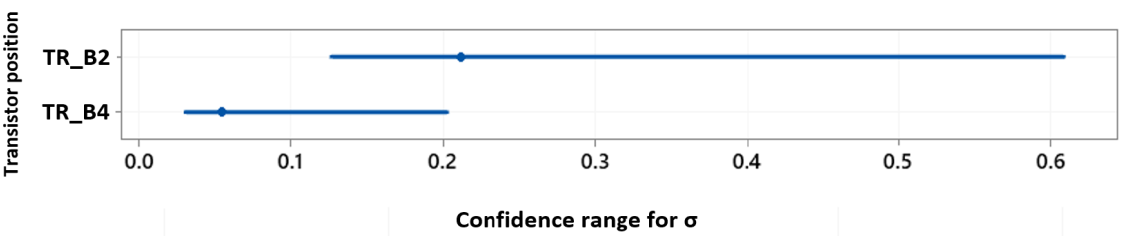
Figure 9. Two variances test in the Minitab for R thaverage and the transistor TR_B in the positions 2 and 4 in PCB modules.